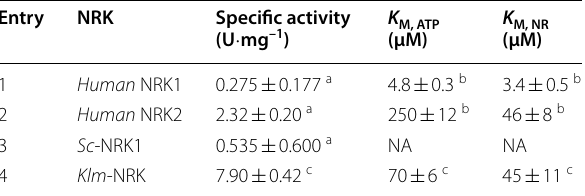
Table 1 Comparison of nicotinamide riboside kinases